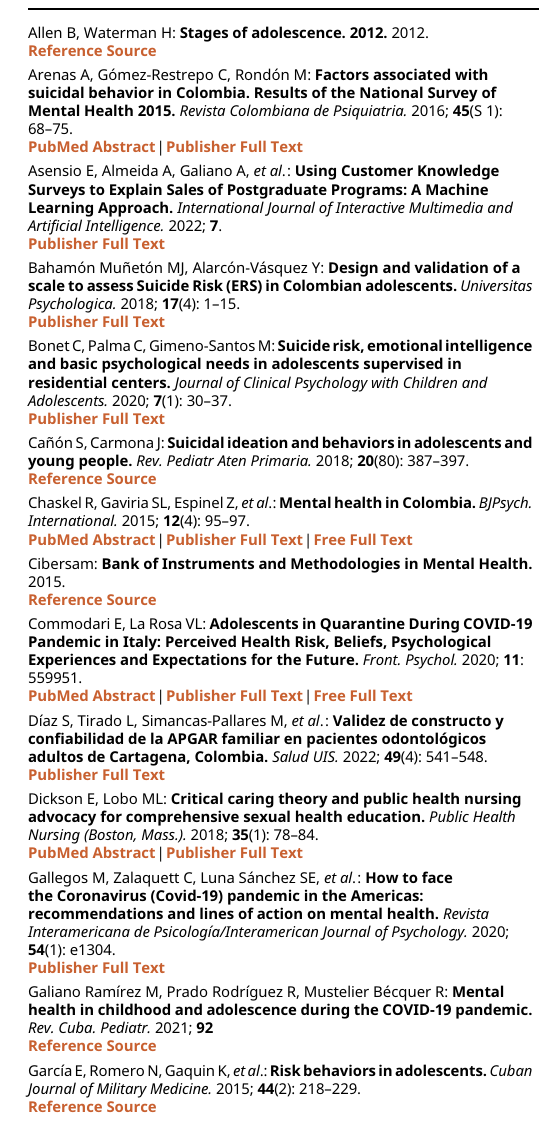
(cid:129) Family Apgar instrument. (Blank copy of the Family Apgar instrument with English and Spanish versions). (cid:129) Annex web link of project information. (Link to send information on project to participants, parents, and